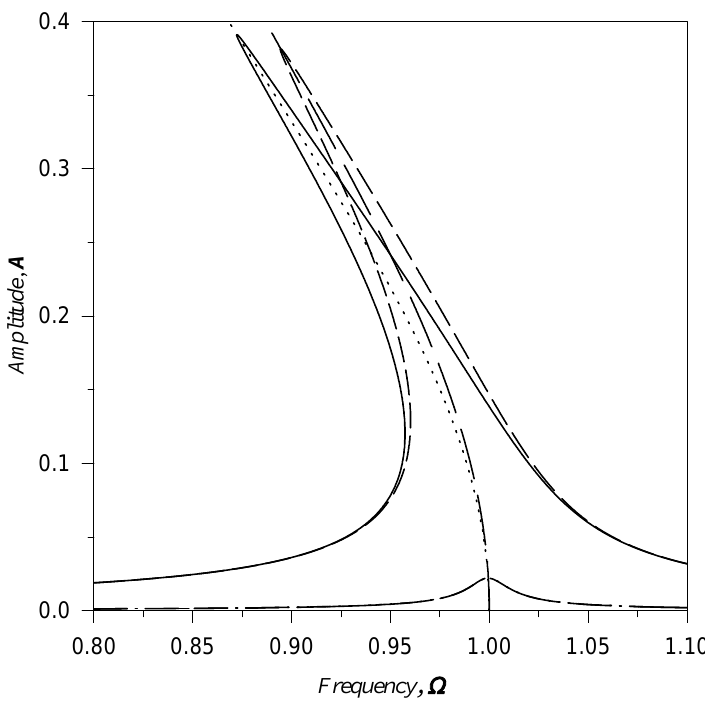
Fig. 9. Same as Fig. 8, but for the case ε 1 = 5 . 78828 , ε 2 = 1 . 25469 , ε 3 c = 0 . 006133 , δ = 0 . 02 and P = 0 . 2 corresponding to the second mode of the wet beam with concentrated load and the case ε 1 = 6 . 58141 , ε 2 = 1 . 25469 , ε 3 c = 0 . 006133 , δ = 0 . 02 and P = 0 . 2 corresponding to the second mode of the dry beam with concentrated load